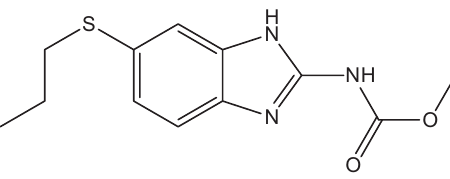
FIGURE 1 – Chemical structure of